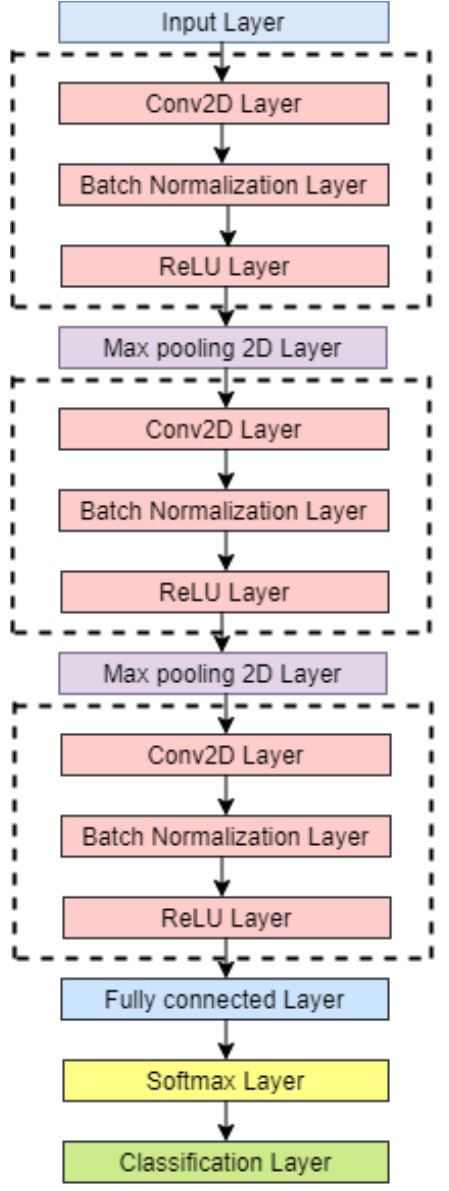
Figure 2. Proposed compact CNN model for